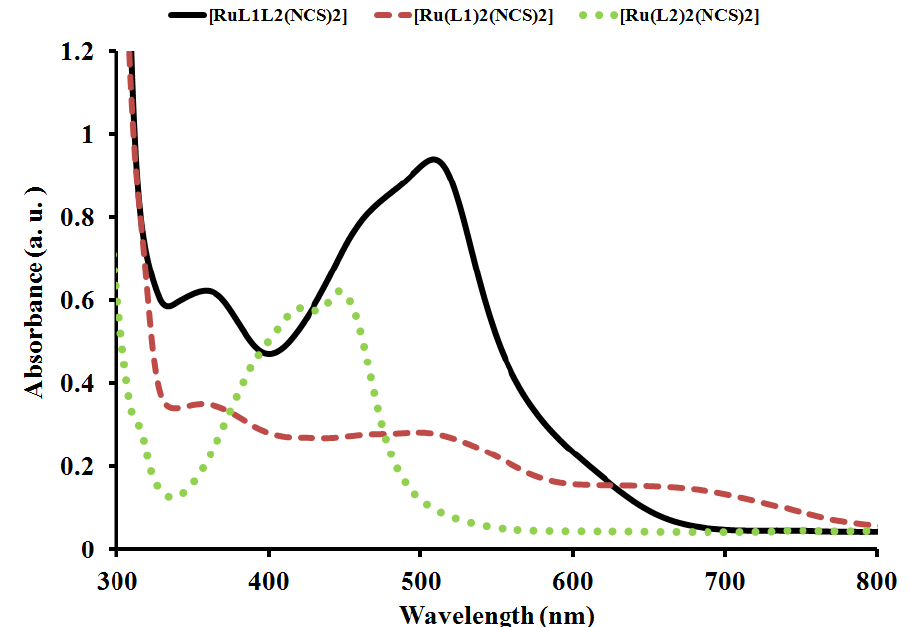
Figure 3. Comparison of the UV-Vis absorption spectrum of [RuL with [Ru(L 1 × 10 − 3 M − 1 in DMF solution showing effect of extended π -conjugation and mixed-ligand